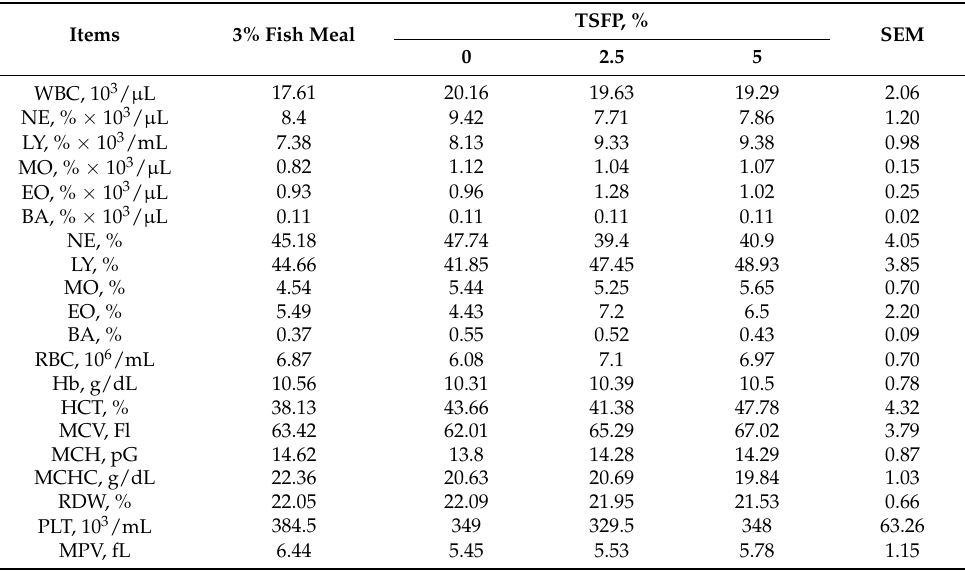
Table 5. Effect of TSFP on hematological traits of finishing